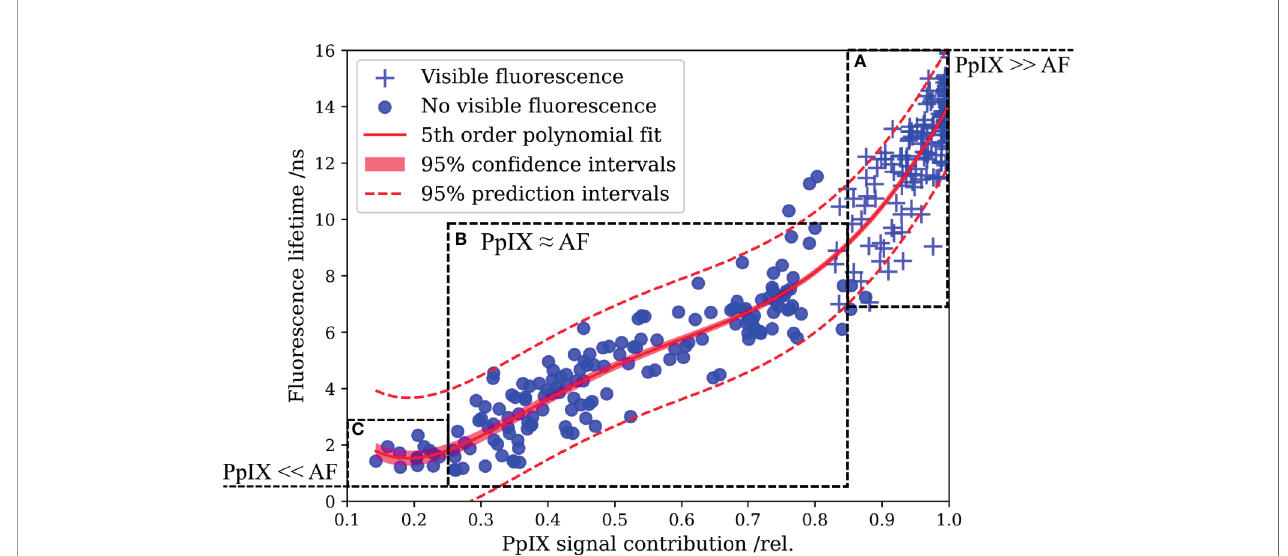
FIGURE 2 | Correlating the fl uorescence lifetime with the relative PpIX signal contribution (RSC PpIX ) obtained from spatially registered spectroscopic measurements reveals the enhanced delineation of PpIX from tissue auto fl uorescence by means of FD-FLIM. (A) PpIX fl uorescence exceeds tissue auto fl uorescence, and vague to strong intraoperative fl uorescence was perceived from about 0.85 to 1.0 RSC PpIX . (B) Auto fl uorescence dominates the overall signal and tissue lacked intraoperative PpIX fl uorescence. Increased fl uorescence lifetimes facilitate the delineation of PpIX fl uorescence from the overall auto fl uorescence background. (C) Fluorescence lifetimes in the magnitude expected for tissue auto fl uorescence were measured for small RSC PpIX <